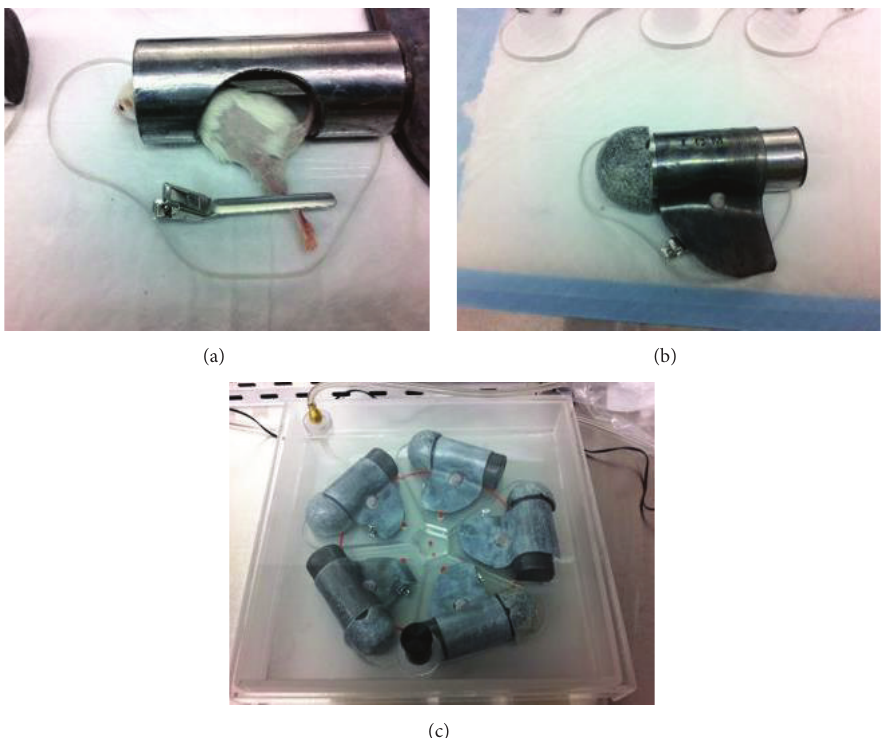
Figure 1: Fractionated radiation therapy was selectively administered to each animal. A specialized jig was designed and built out of lead in order to ensure that only the gene-modified dorsal aspect of the left hind leg was exposed to the radiation beam (a, b). Five animals at a time were anesthetized and placed in a radiation chamber where they were exposed to 5 Grays of radiation at a dosage rate of 1Gy/min (c). This protocol was carried out for ten consecutive days for a cumulative dose of 50